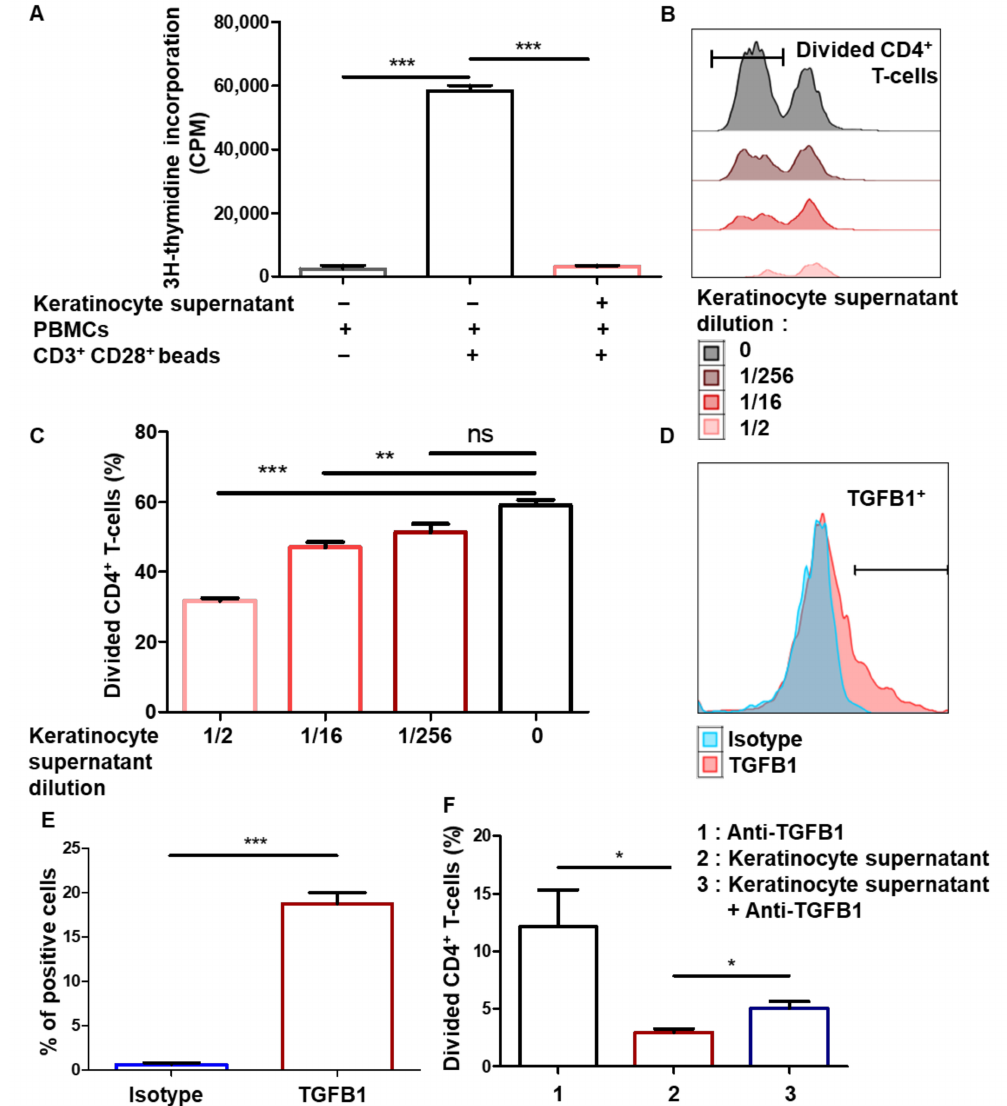
Figure 3. Immunomodulation mediated by amplified keratinocytes involves soluble factors. ( A ) Keratinocytes from 3 different donors were amplified for 2 days. Then, supernatants were incubated or not with 100,000 PBMCs for 5 days. PBMCs activated by CD3 + CD28 + beads were used as positive controls. PBMC proliferation was quantified by thymidine incorporation at day 5 (mean + SEM, p < 0.05, n = 3). ( B,C ) Different concentrations of keratinocyte supernatant from 1 representative donor were incubated with 100,000 PBMCs for 7 days. PBMCs were pre-marked with a proliferation dye. PBMCs were activated by CD3 + CD28 + beads. PBMC proliferation was quantified by dye decrease at day 7. ( B ) Representative flow cytometry profiles at day 7. ( C ) CD4+ T-cell proliferation inhibition as a function of keratinocyte supernatant dilution (mean + SEM, p < 0.05, n = 3). ( D , E ) Flow cytometry analysis of TGFB1 levels in keratinocytes. ( F ) CD4 + T-cell proliferation assay with TGFB1 blocking. Exact p-values were determined using the t -test. *: p < 0.05 and **: p < 0.01 and ***: p < 0.001 n =